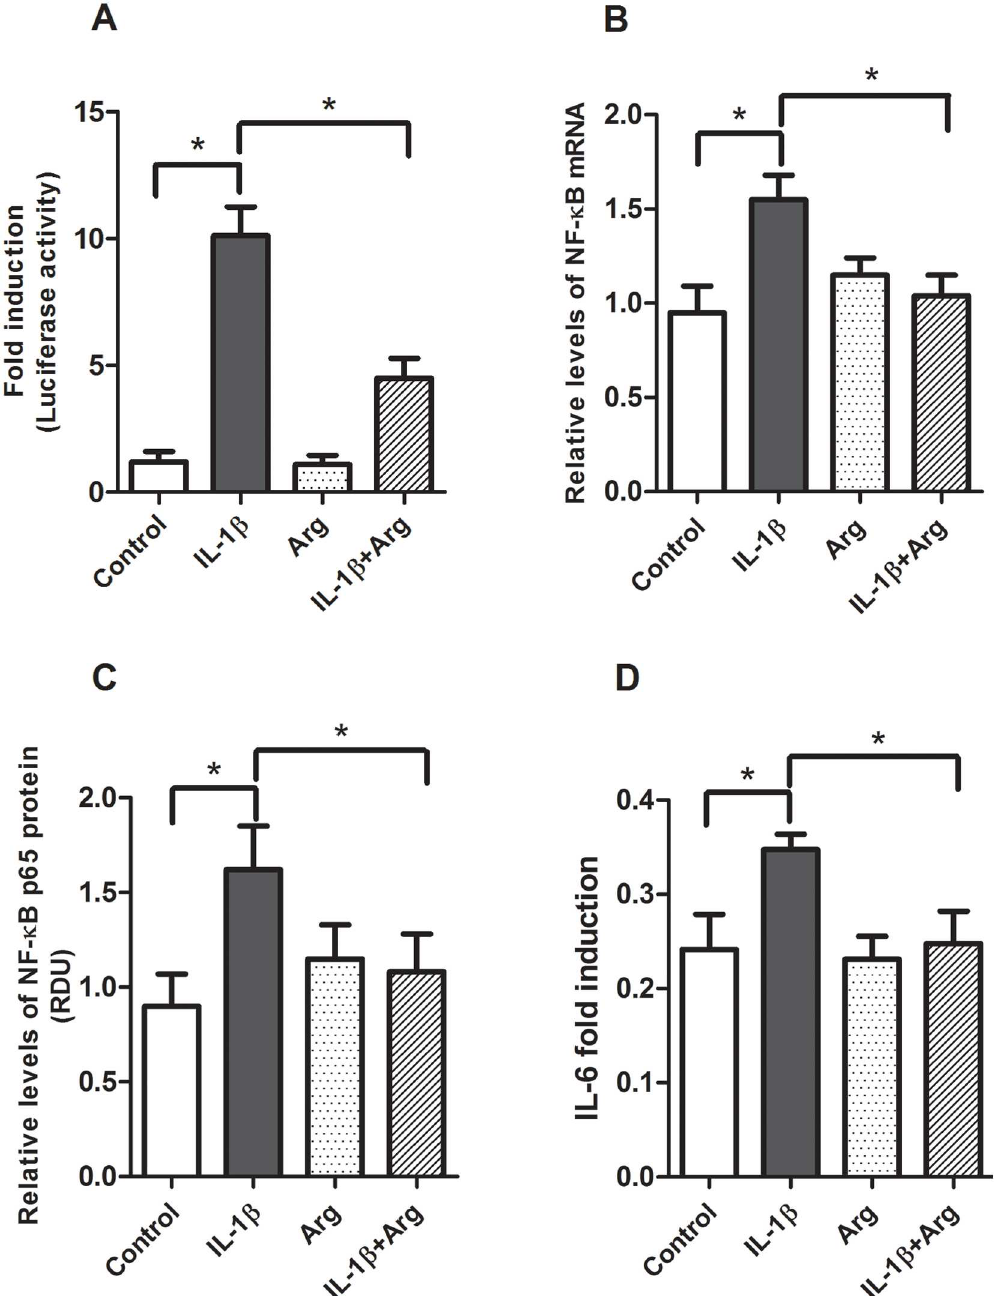
Fig 2. Effects of L-Argon IL-1 β -induced NF- κ B promoter activity, expression and IL-6 production. Caco-2 cells transfected with pNF- κ B-Luc vector were treated with or without IL-1 β (4 ng/ml) for 4 hours after pretreatment in the absence or presenceof L-Arg (5 mM) for 4 hours (Fresh medium with L-Arg was appliedafter removingmedium for pre-treatment). Cells were harvestedfor luciferaseactivity, isolations of total RNA and protein. A: NF- κ B luciferase activity data are expressed as fold inductionof normalizedluciferase activity. B: NF- κ B mRNA levels were determined by qRT-PCR, then normalizedto β -actin. C: NF- κ B p65 protein levels were measuredby Western blot analysisand normalized to β -actin. D: IL-6 levels in the cell culture media were measuredby ELISA, normalized to total protein and expressedas fold-induction. All data are means ± SE, * P < 0.05. (n = 5–6 /group).